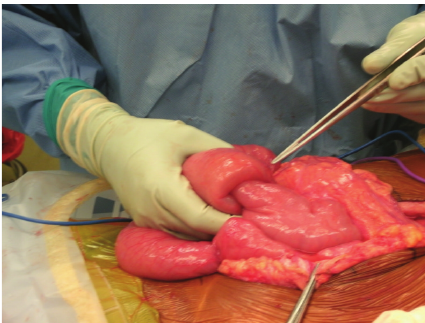
Figure 2: Intussuscepted bowel.